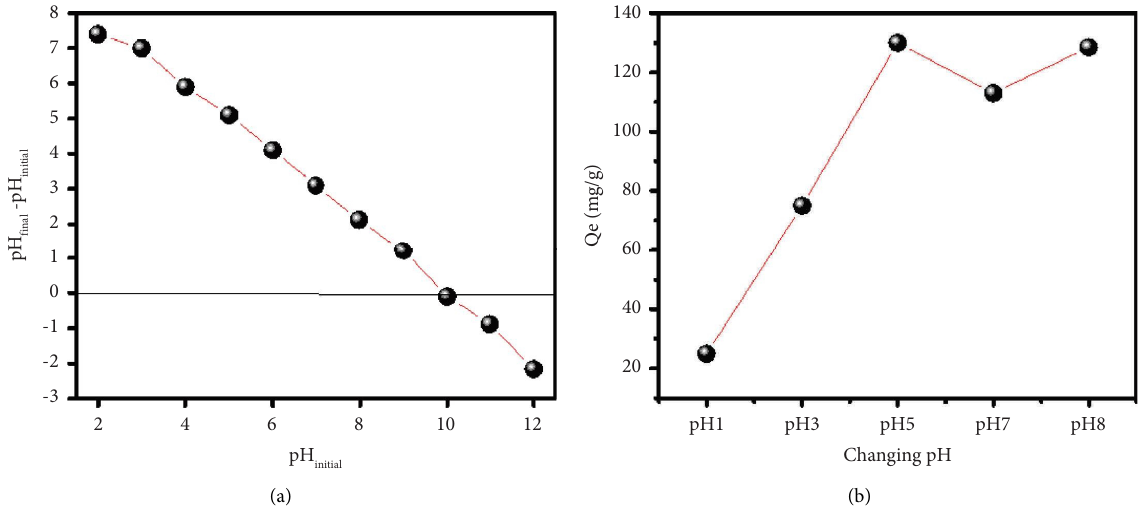
Figure 5: (a) pH point of zero charge (pHpzc) and (b) efect of pH on the removal capacity (mg/g) of Co (II) onto CaO.MgO